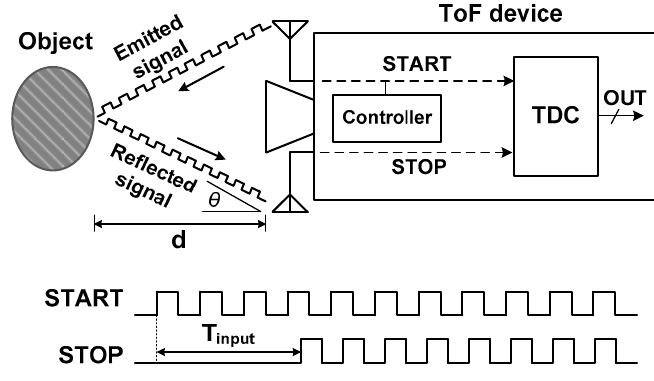
Figure 1. Operation of a time-of-flight (TOF) sensor. TDC: time-to-digital converter; STARTS: signal emission; STOP: detection.